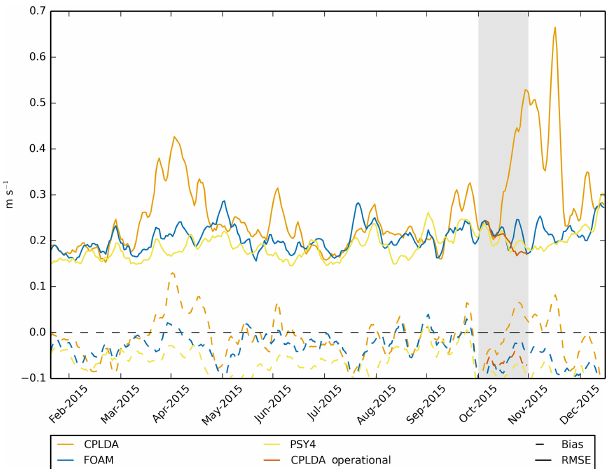
Figure 11. The 15m velocity using class 4 statistics with respect to velocities derived from drifting buoys for 2015. RMSE and mean bias are shown for CPLDA and FOAM, as well as PSY4 and, for a short test period, CPLDA using the operational scheduling, allow- ing for the assimilation of additional SLA